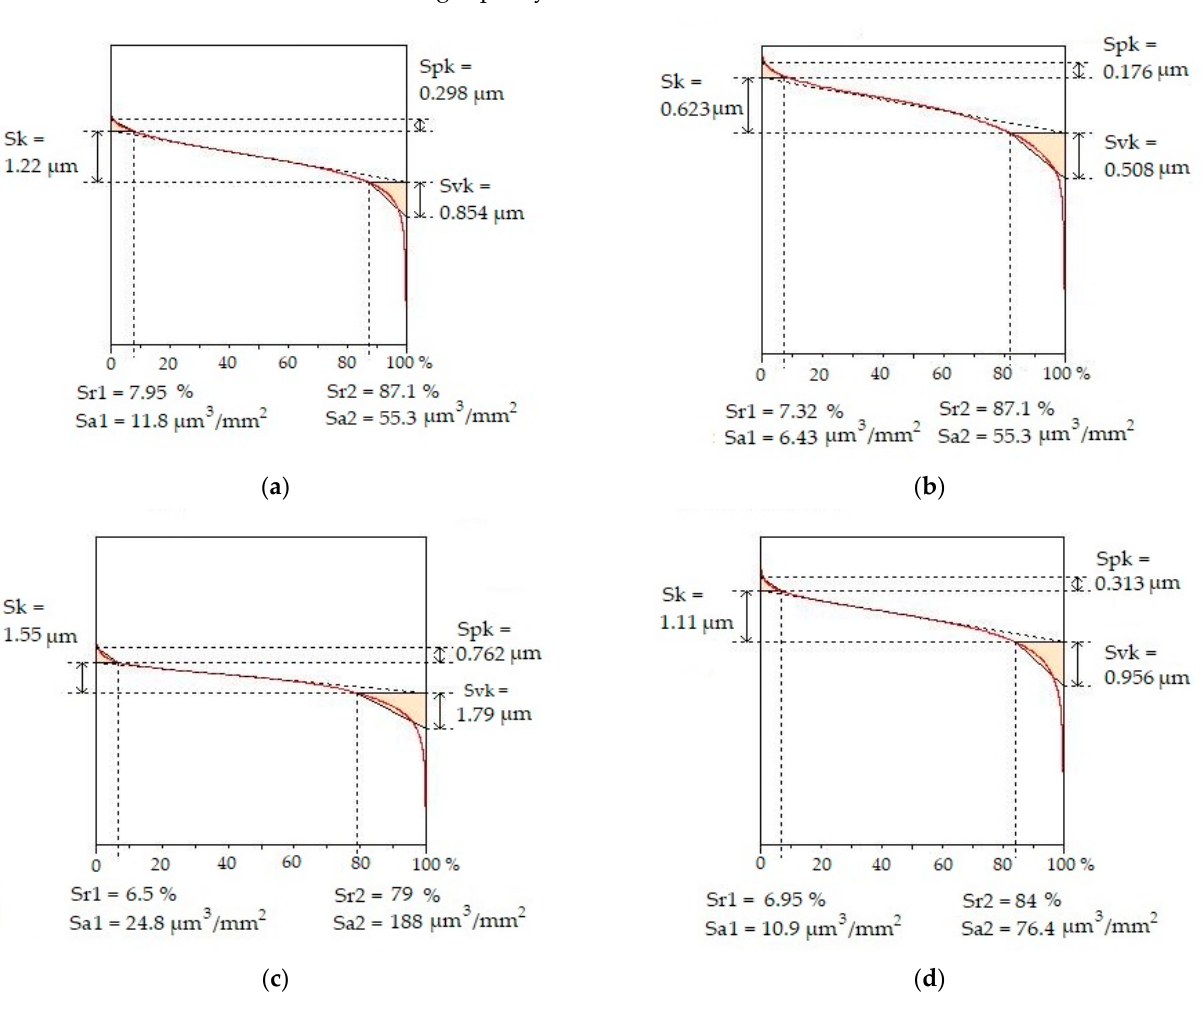
Figure 8. Load-bearing capacity (Abbott–Firestone) curves: ( a ) sample 01K, ( b ) sample 02G, ( c ) sample 02H, ( d ) sample 02K.